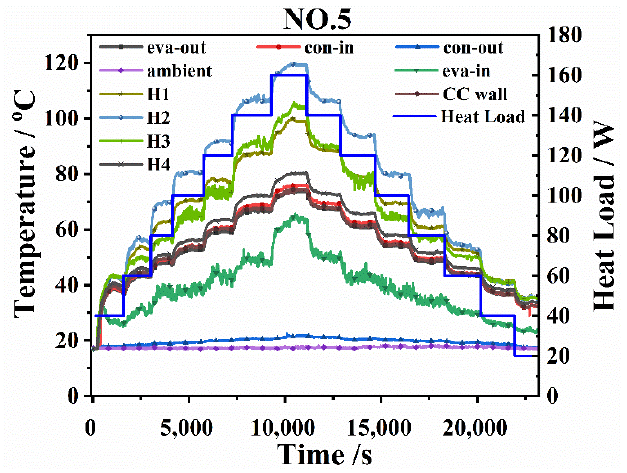
Figure 14. Temperature response during continuous operation of No.5 position at 20 W-160 W-20